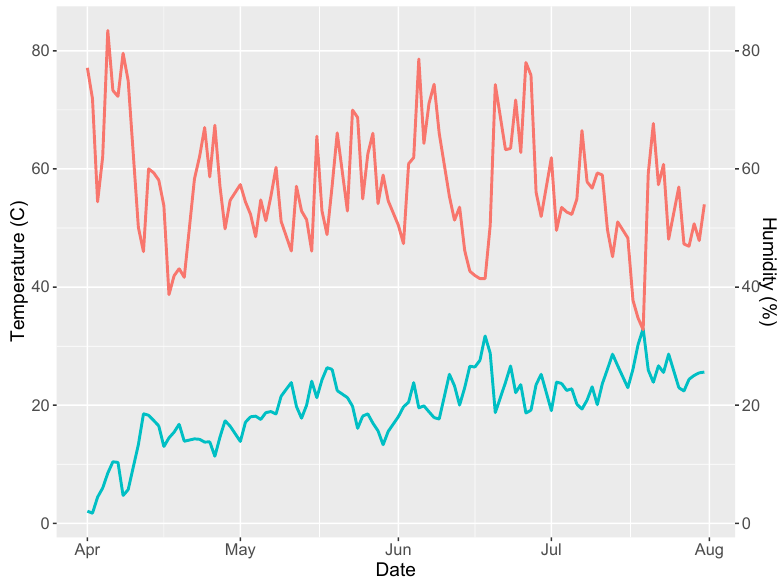
Figure 3. Visualization of the climate conditions recorded by Sensor 1. The blue line indicates temperature, while the red line shows